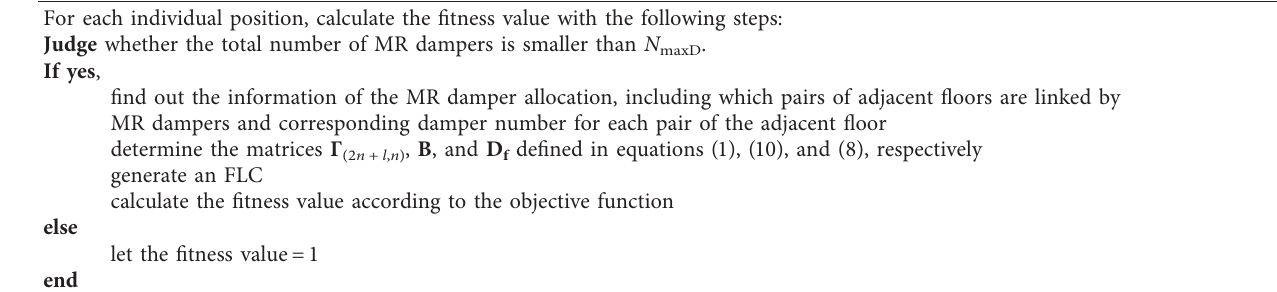
Table 2: The pseudocode of Step 9 of the design process.